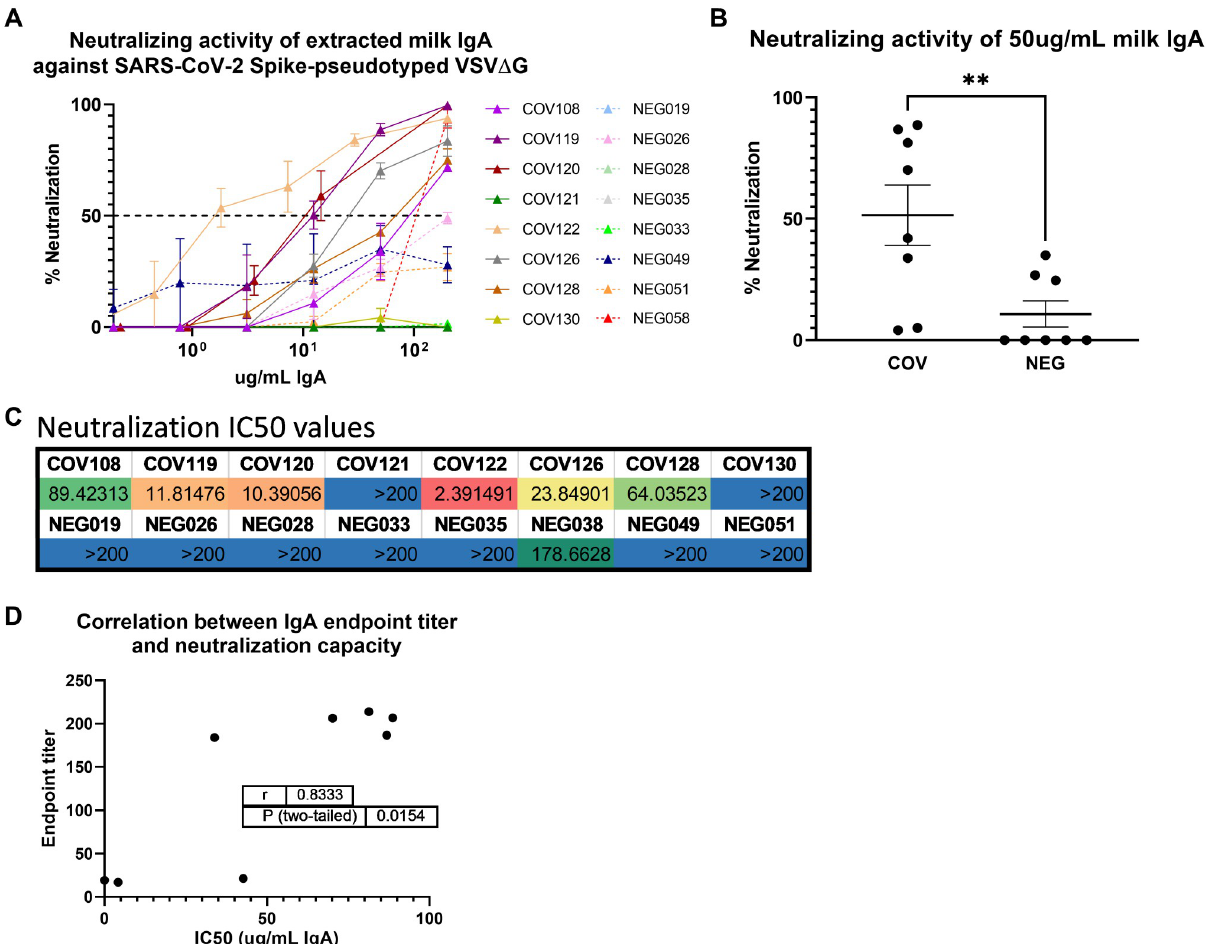
Fig 4. Extracted milk IgA from COVID-19-recovered donors exhibits SARS-CoV-2 Spike-targeted neutralization potency that is highly correlated with IgA binding activity. (A) Total IgA was purified from 8 COVID-19 and 8 control milk samples by conventional means using peptide M agarose. IgA was titrated and tested in a VSV-based SARS-CoV-2 pseudovirus neutralization assay. NEG/segmented lines: pre-pandemic controls. COV/solid lines: COVID-19-recovered milk samples. Segmented line: 50% neutralization cutoff value. (B) Percent neutralization achieved using 50ug/mL of total extracted milk IgA. Mean values with SEM are shown. �� p = 0.0064. Mann-Whitney U test (2-tailed) was used to compare grouped data with significance level set at p < 0.05. (C) Neutralization IC50 values determined from IgA titration curves. (D) Endpoint titer values determined in Fig 1 and IC50 values were used in a 2-tailed Spearman correlation